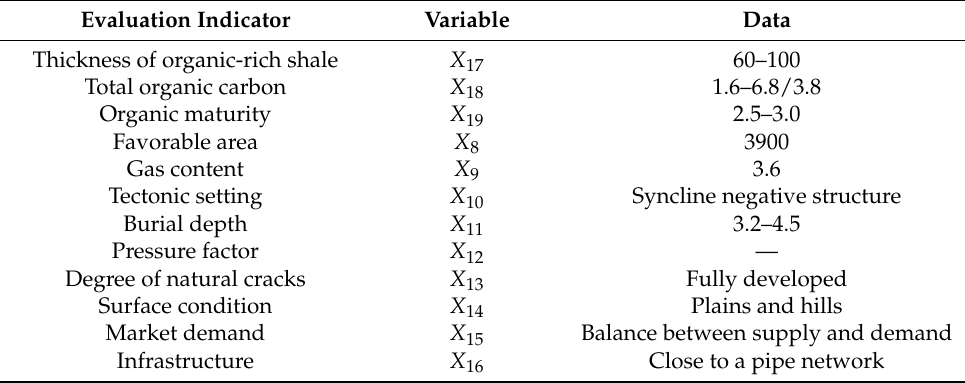
Table 8. Data on the oil layer group in